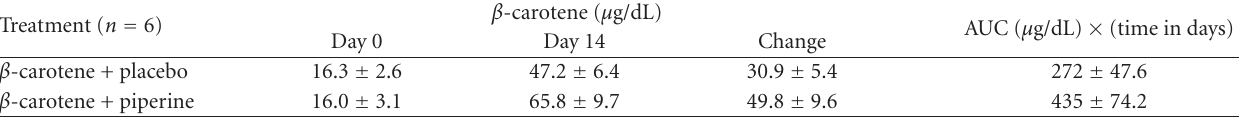
Table 6: E ff ect of piperine on the serum β -carotene levels during a 14-day supplementation in human volunteers [20]. Treatment ( n = 6)